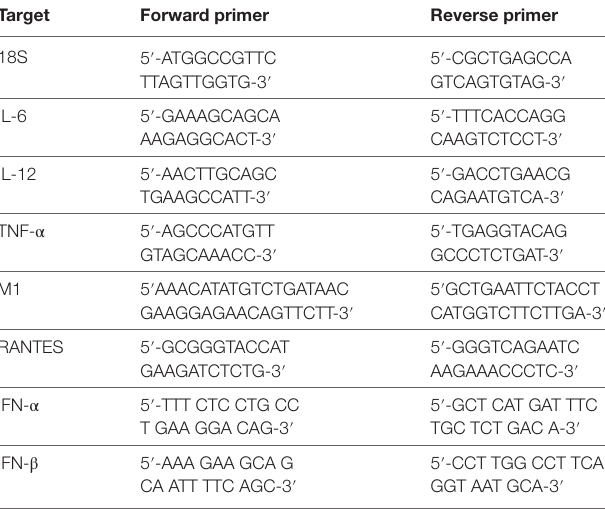
TaBle 1 | Target genes, forward primers, and reverse primers used for qPCR.